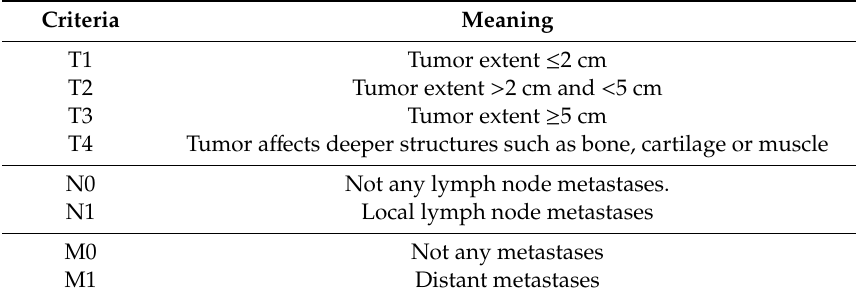
Table 1. TNM-classification of